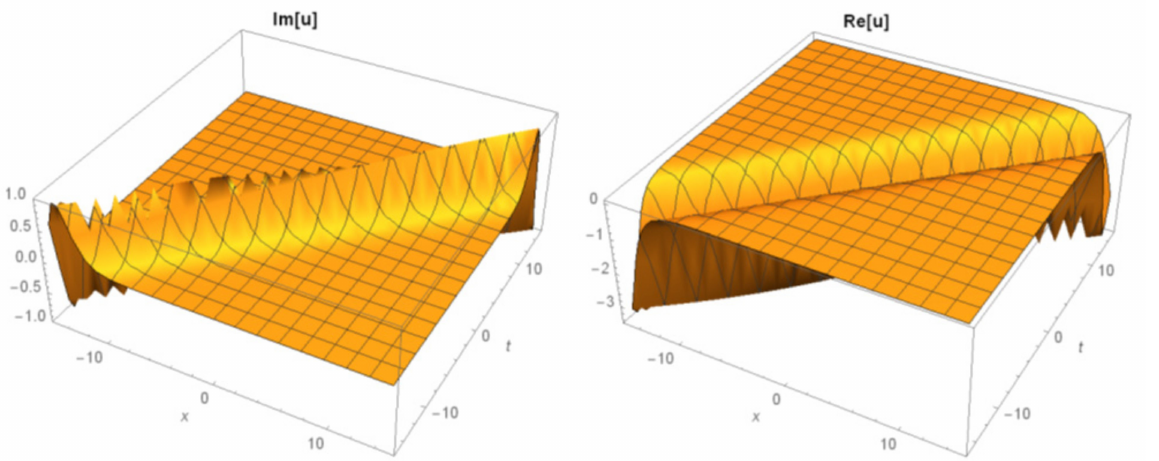
Figure 20. The 3D surfaces of Equation (32) for ε = 0.4, α = 0.1, − 15 < x < 15, − 15 < t < 15.